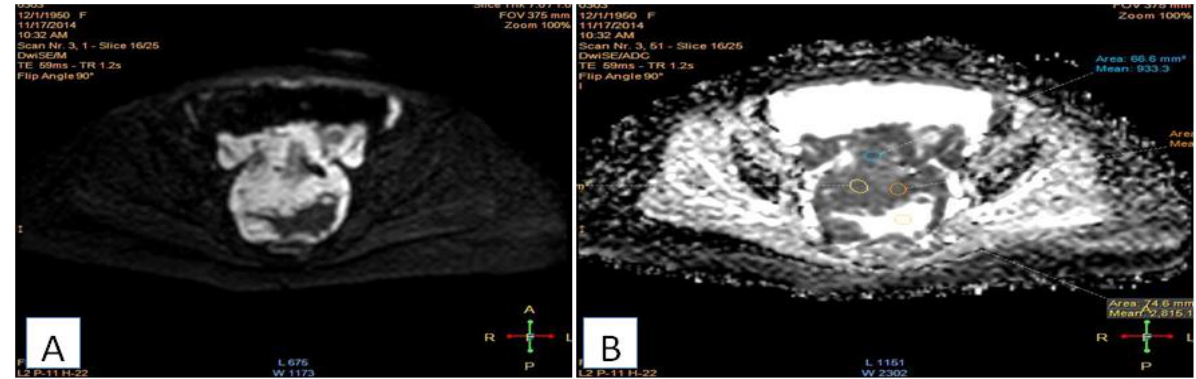
Figure (3): 71 years old female with RT ovarian mucinous cysts adenocarcinoma (a)axial DWI obtained at b value 1000 s/mm 2 reavel the solid component hyper intense (b)shows that the tumor had hypoinsity within the solid component with low ADC value =0.93 x10 -3 mm 2